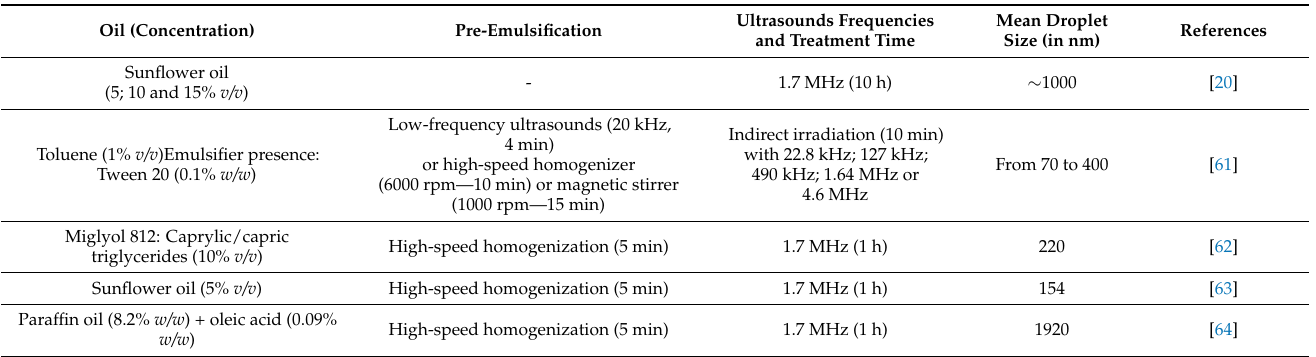
Table 2. Characteristics of emulsions produced by single high-frequency ultrasounds